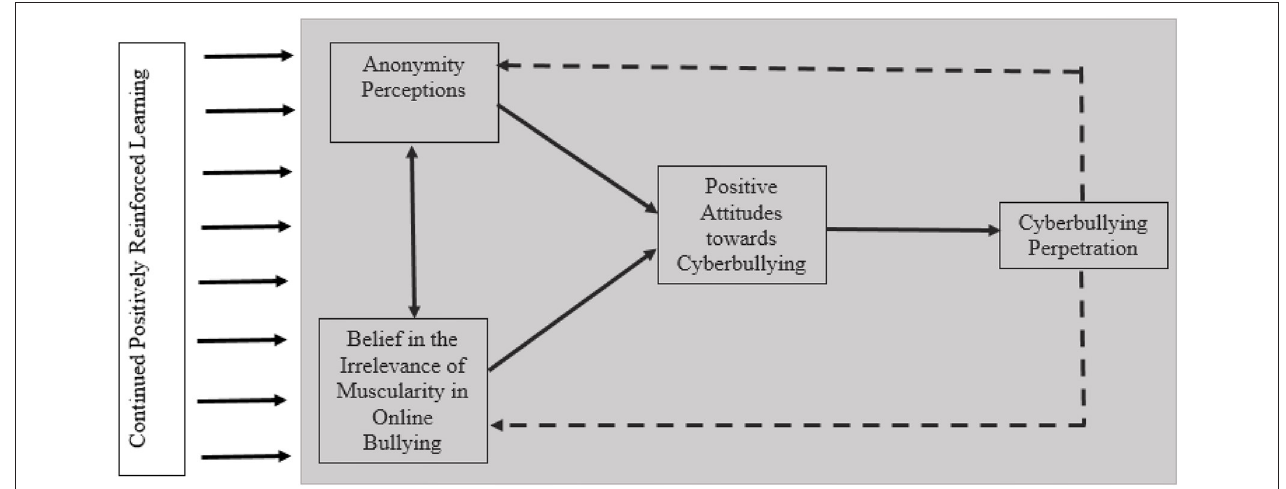
FIGURE 1 | The Barlett Gentile Cyberbullying Model (BGCM).